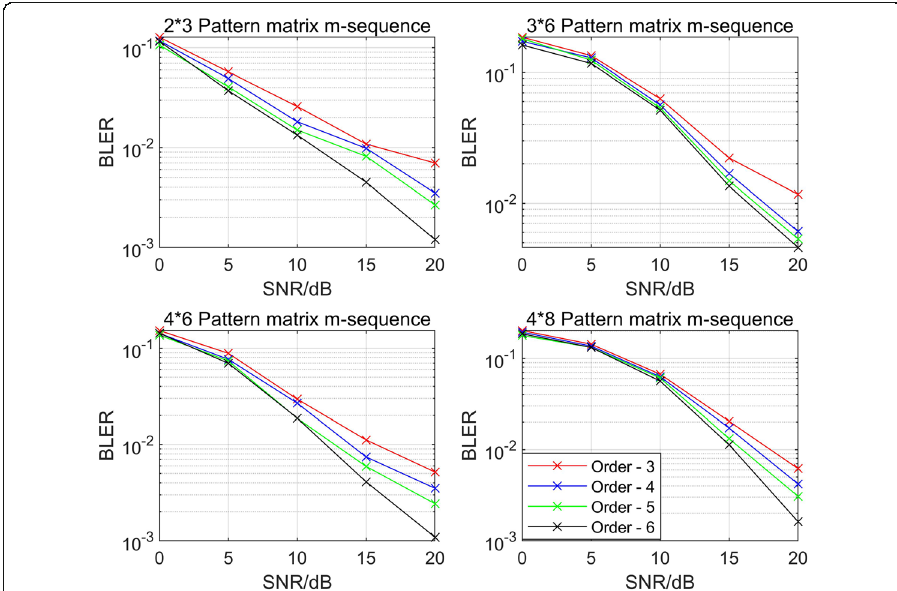
Fig. 6 m-sequence spread spectrum based on PDMA pattern matrix with different dimensions. The spread spectrum performance comparison of m-sequence of order 3, order 4, order 5, and order 6 under different dimensional pattern matrices. The dimension of pattern matrix is 2 (cid:5) 3